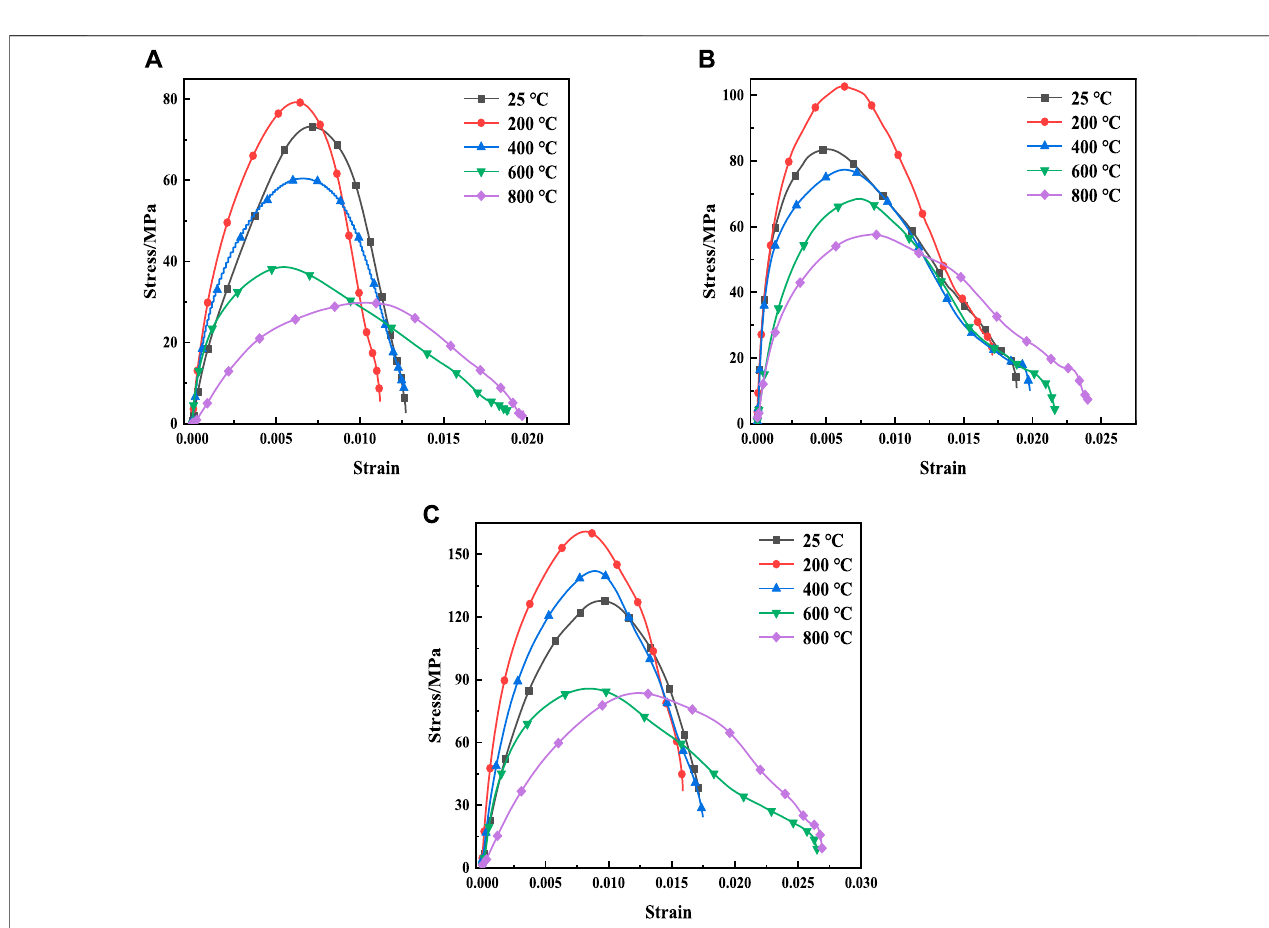
FIGURE4| Dynamicstress – straincurvesofgranitespecimensaffectedbydifferenttemperaturesatdifferentimpactvelocitiesof (A) 8.5 m/s, (B) 11.5 m/s,and (C) 13.5 m/s.